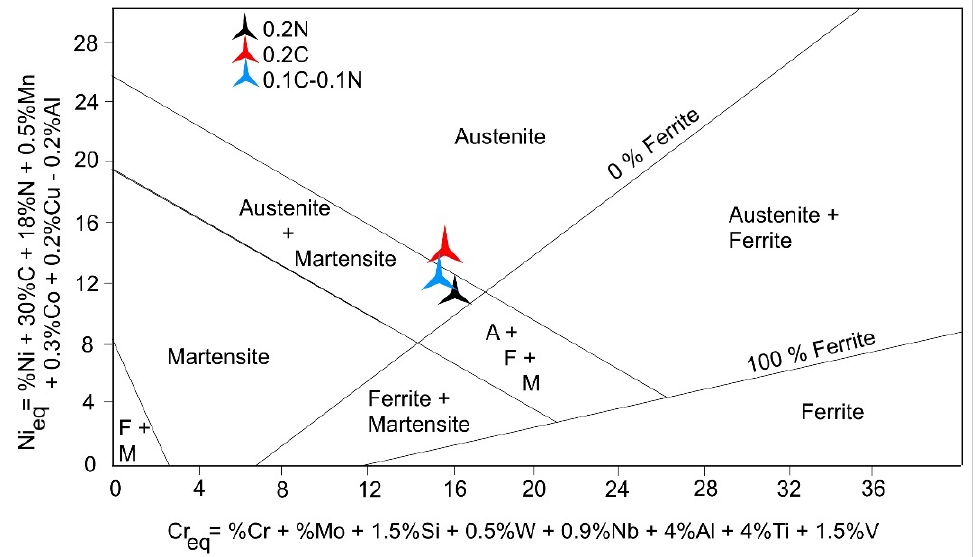
Figure 1. Positions of the examined steels in the Schaeffler diagram. The red and the black asterisks mark the steels with 0.2 wt.% C and 0.2 wt.% N, respectively. The steel containing 0.1 wt.% C and 0.1 wt.% N is indicated by a blue